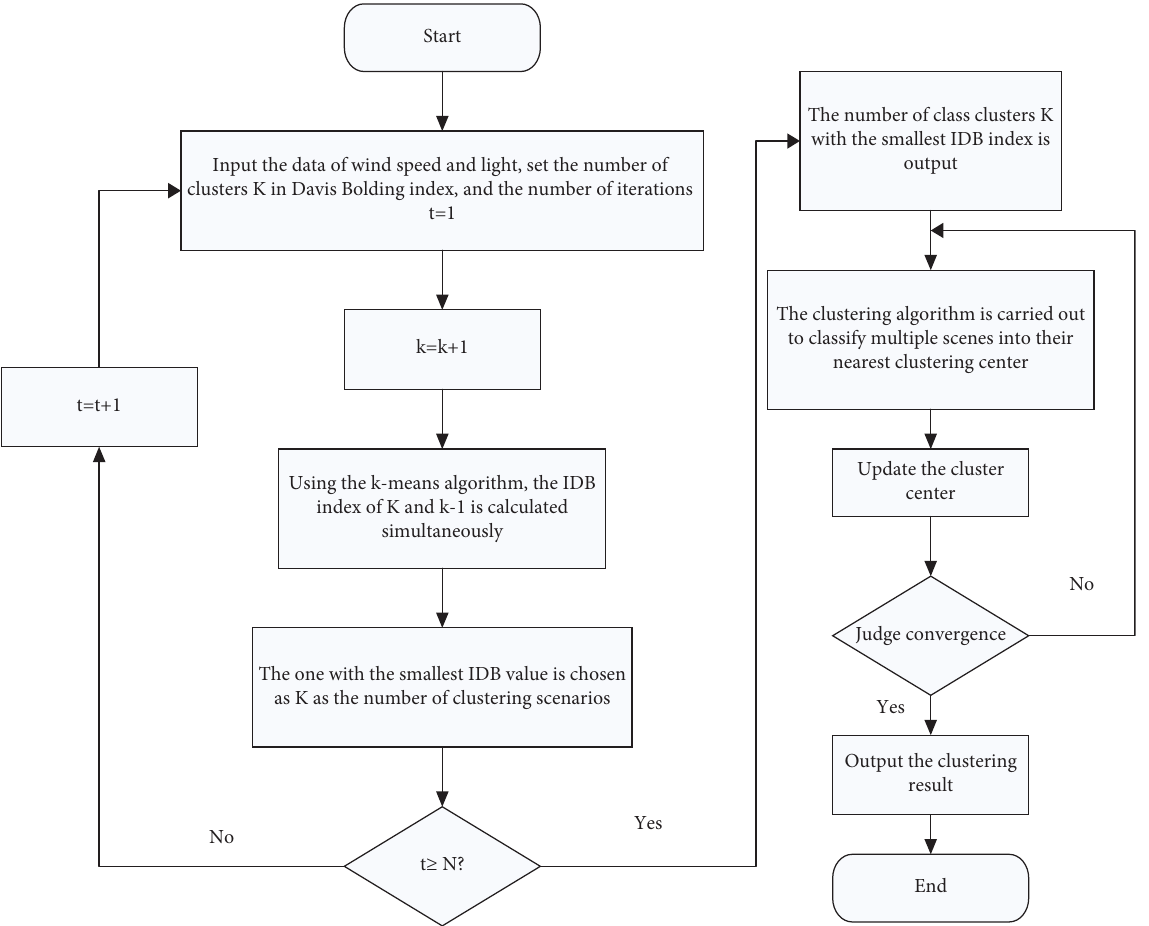
Figure 1: Generation of scenarios based on k-means with